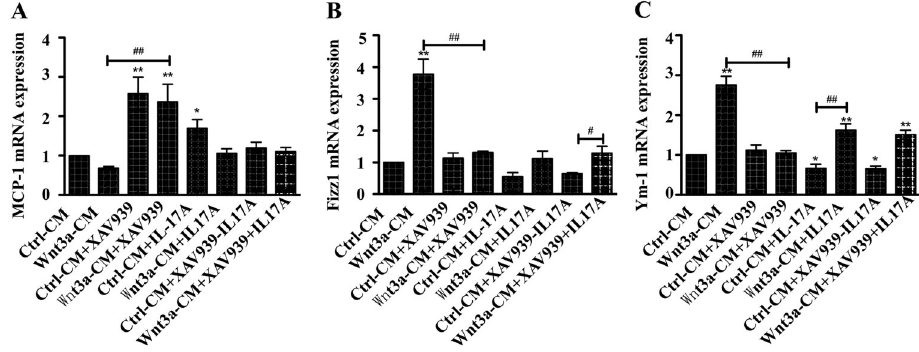
Figure 3. Expression of key macrophage characteristic genes in RAW264.7 cells in response to Wnt3A and/or IL-17A stimulation. A – C , Relative expression of Mcp1 , Fizz1 , and Ym-1 genes of the fold-change over control of transcript in cells treated with Wnt3a-CM and/or XAV939 without rhIL-17A or with rhIL-17A. Data are reported as means ± SD from three independent experiments. *P o 0.05, **P o 0.01 compared to the Ctrl-CM group; # P o 0.05, ## P o 0.01 compared to the indicated groups (ANOVA).